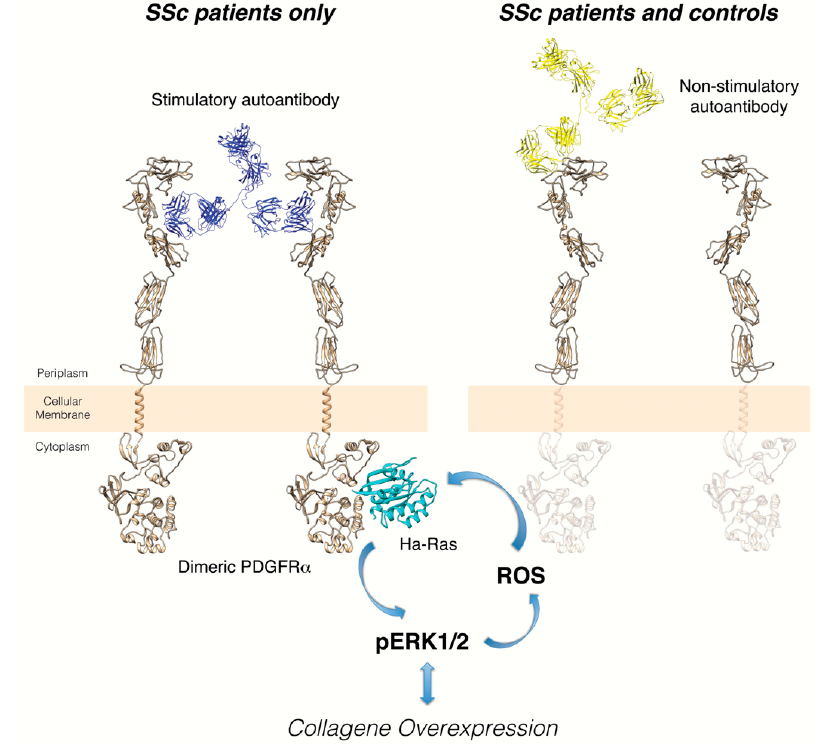
Figure 1. Distinct epitopes of stimulatory and non-stimulatory anti-PDGFR α autoantibodies. Left cartoon: the interaction of stimulatory autoantibody cloned from memory B cells of a scleroderma patient and the discontinuous, conformational epitope identified on the extracellular PDGFR α domain induces the intracellular signaling activation and collagen gene overexpression. The identification of this binding region of PDGFR α provides a possible target for new therapeutic strategies to block excessive collagen synthesis under pathologic conditions such as SSc. Right cartoon: binding of non-stimulatory autoantibodies cloned from memory B cells of the same scleroderma patient to a single linear epitope of extracellular PDGFR α domain does not induce receptor dimerization/activation. This non-agonistic autoantibody could reflect the natural autoimmunity, already observed in many healthy individuals, without any clear role in physiology or disease.